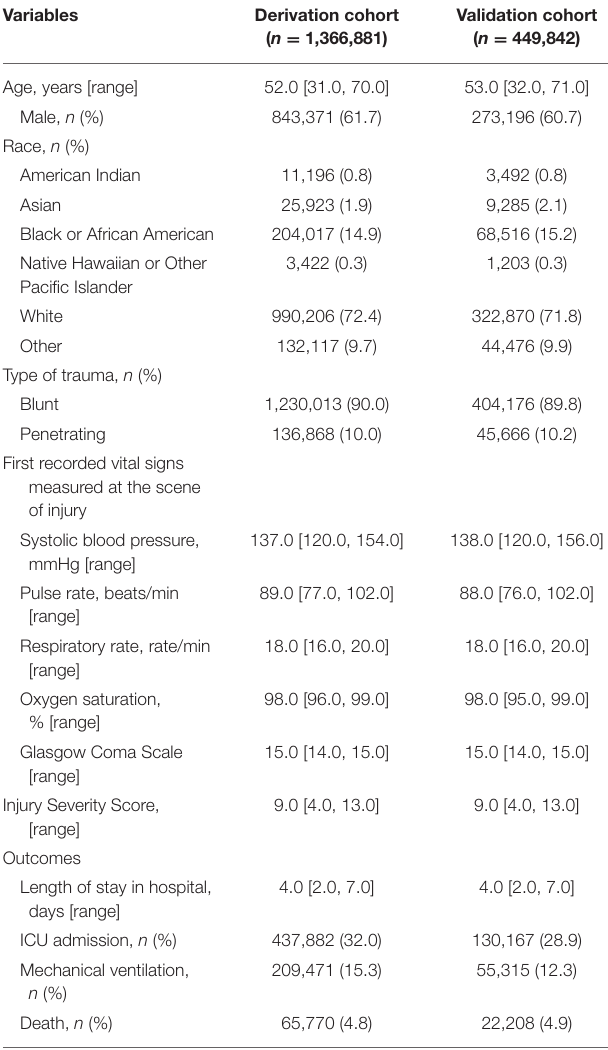
TABLE 1 | Baseline characteristics of trauma